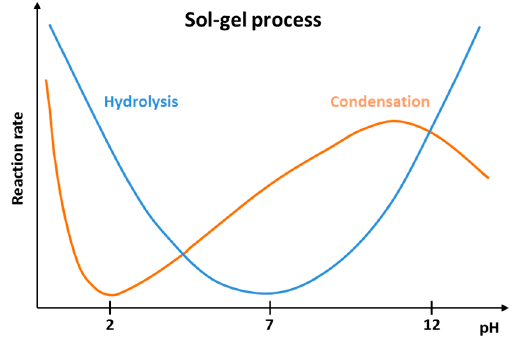
Figure 3. pH effect on the rate of hydrolysis (blue) and condensation (orange) of alkoxysilanes [98].